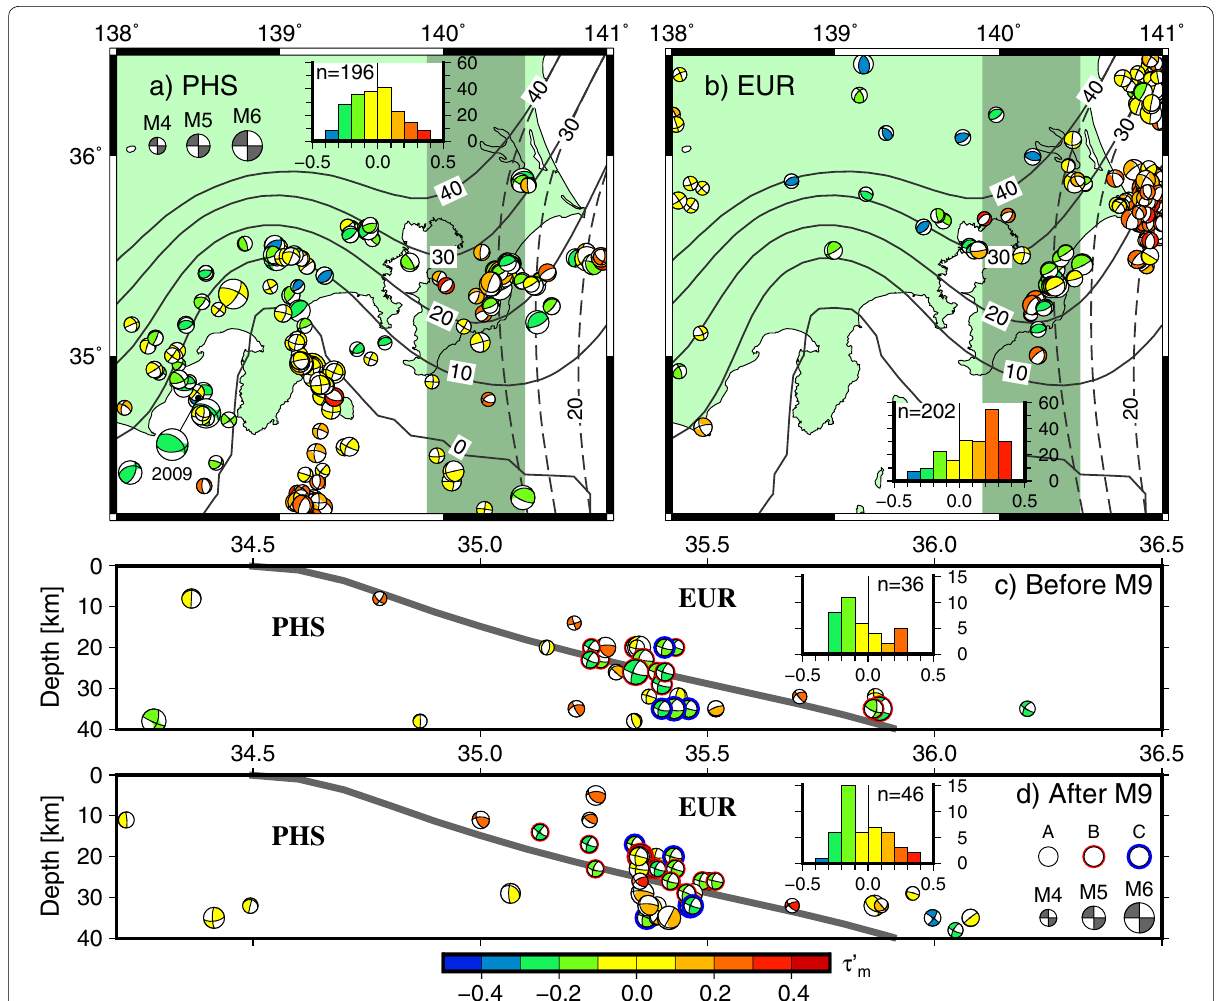
Fig. 2 a , b Focal mechanisms for earthquakes distributed in PHS and EUR plates, from 2003/1/1 to 2019/9/30. Solid and dashed contours denote upper surface of PHS and PAC plates, respectively. c , d Earthquake mechanisms from PHS and EUR before and after M9 Tohoku earthquake of 2011/03/11, in vertical section. Mechanisms outlined in black, red, and blue denote three groups: (A) major intraplate earthquakes, (B) interplate earthquakes, thrust-type, and (C) anomalous intraplate earthquakes, thrust-type. Range for plots in (c) and (d) marked as shaded strips in panels (a) and (b). All earthquakes from NIED F-net catalog. Focal mechanisms color-keyed to fault types, expressed as normalized mean horizontal moment tensor τ ′ m . Frequency distribution of τ ′ m displayed in histogram. n total number of =